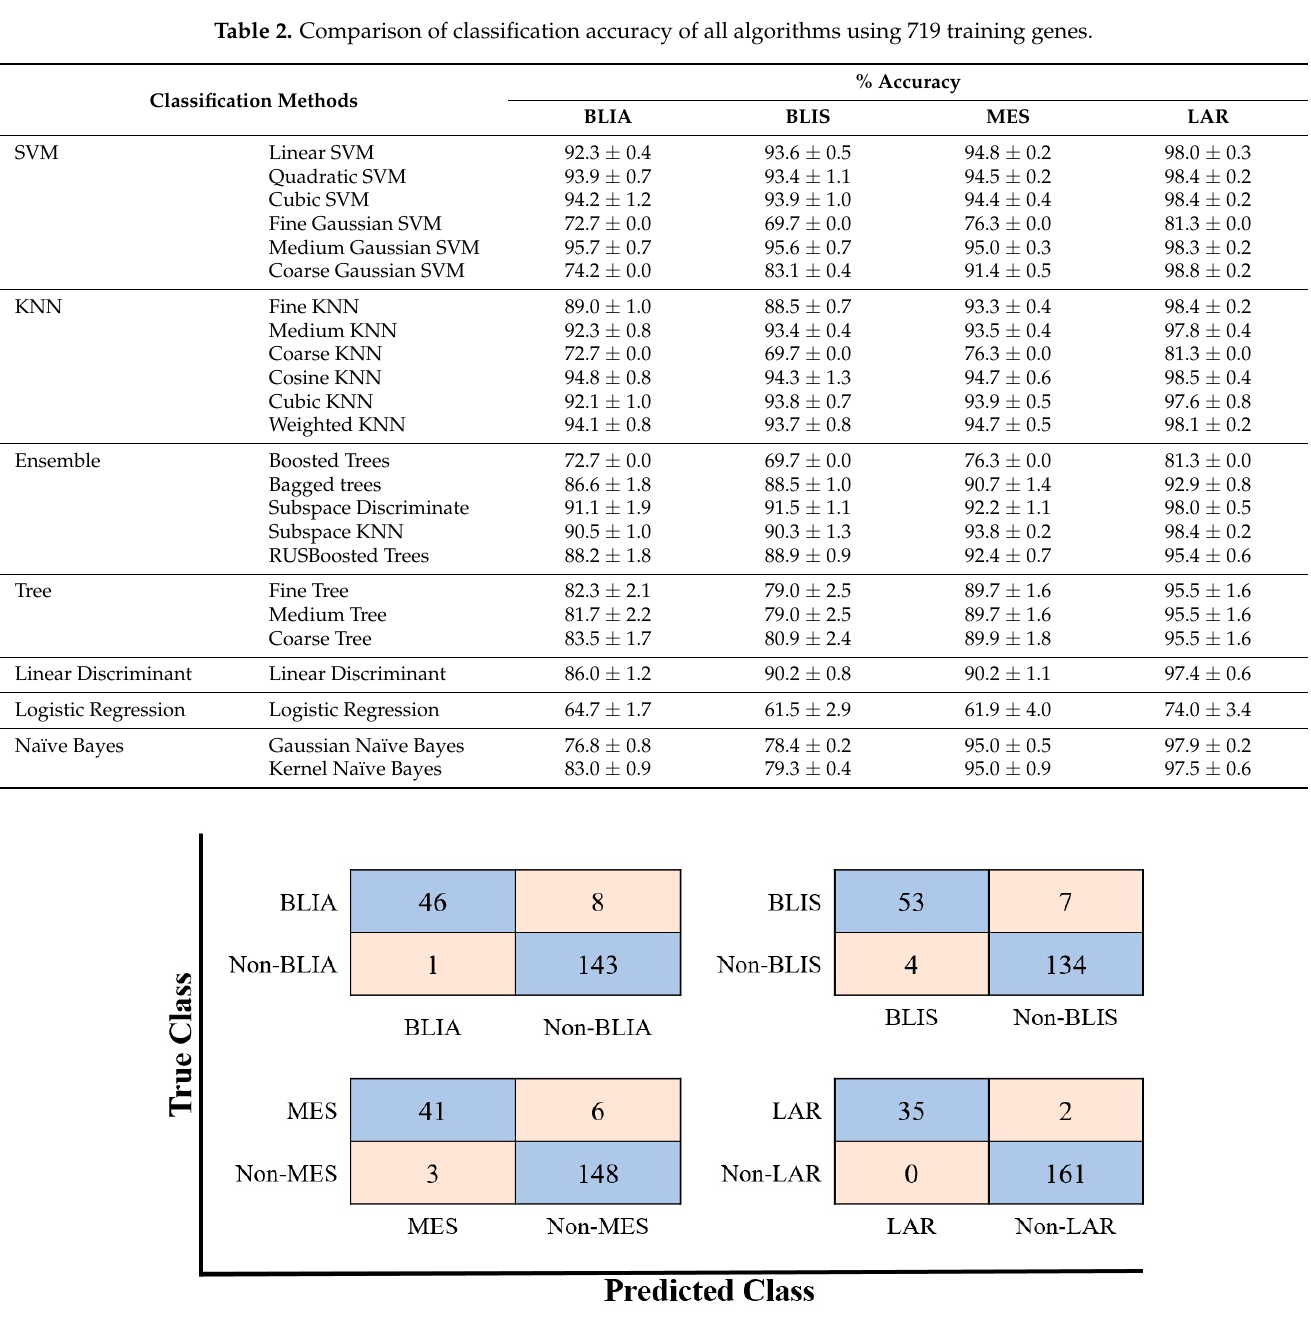
Figure 3. Confusion matrixes of the best performing models using the SVM algorithms. Table 3. Overall performance of four selected classification models.